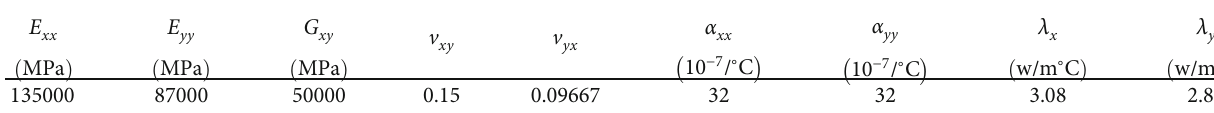
Table 1: Tyrannohex.